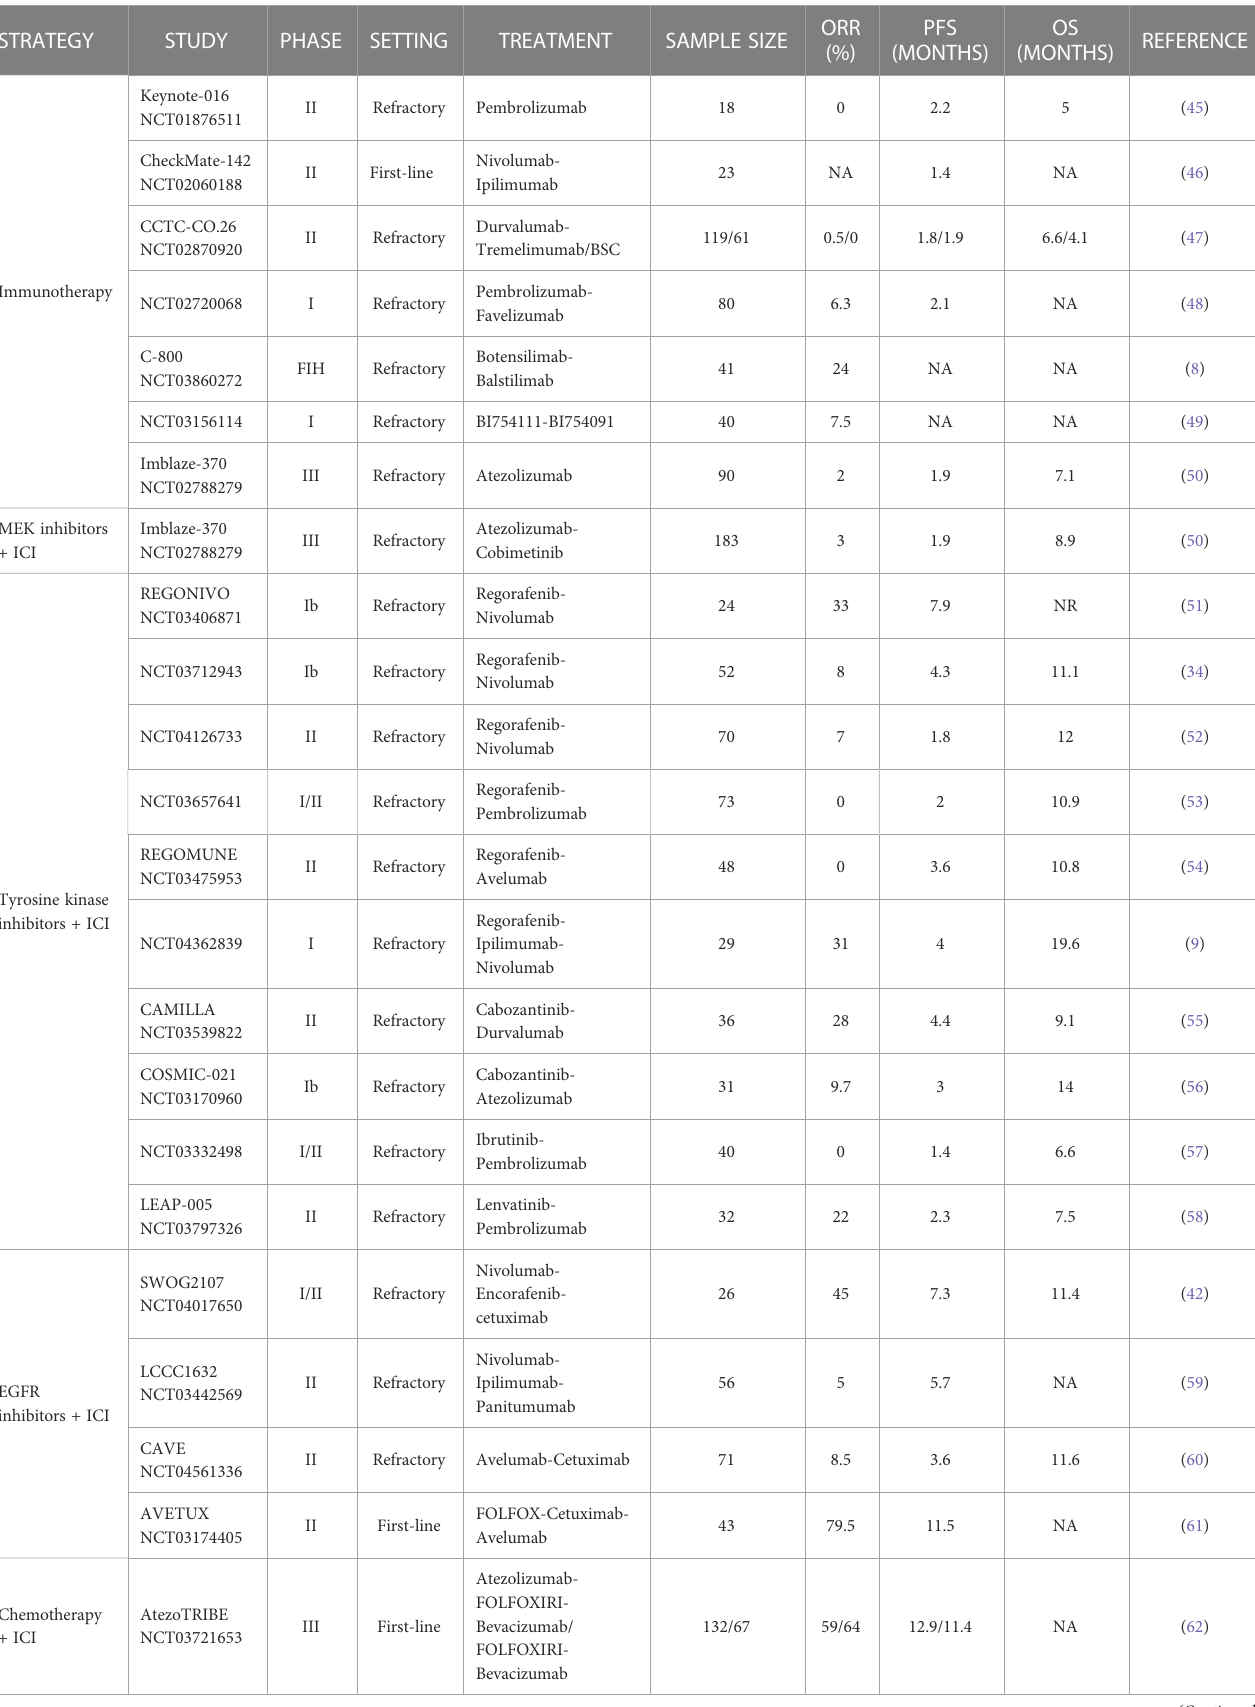
TABLE 1 Completed clinical trials evaluating therapeutic strategies with immune checkpoint inhibitors in MSS mCRC.